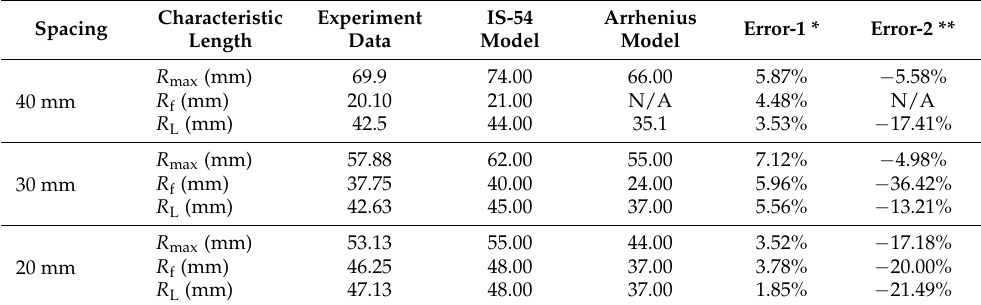
* Error-1 indicates the relative errors between the experimental data and IS-54, ** Error-2 indicates the relative errors between the experiment data and Arrhenius